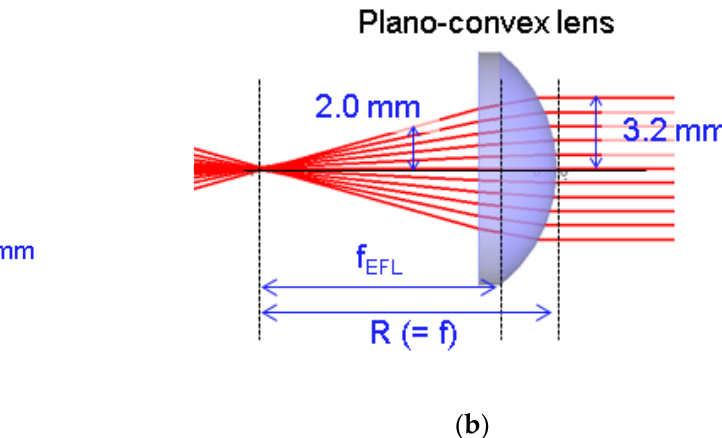
Figure 6. Beam path and phosphor irradiation focal length characteristics with dichroic filter applied: ( a ) changes in blue laser beam path; ( b ) characteristics of initial detection distance according to beam width.